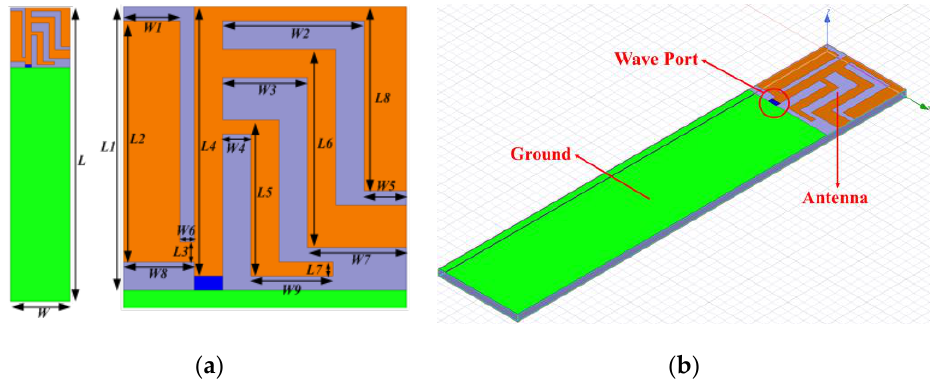
Figure 2. ( a ) The structure and ( b ) HFSS simulation model of the planar Universal Serial Bus (USB) dongle antenna. Table 1. Dimensions of the planar USB dongle antenna: ( a ) length and ( b ) width. (a) Length.